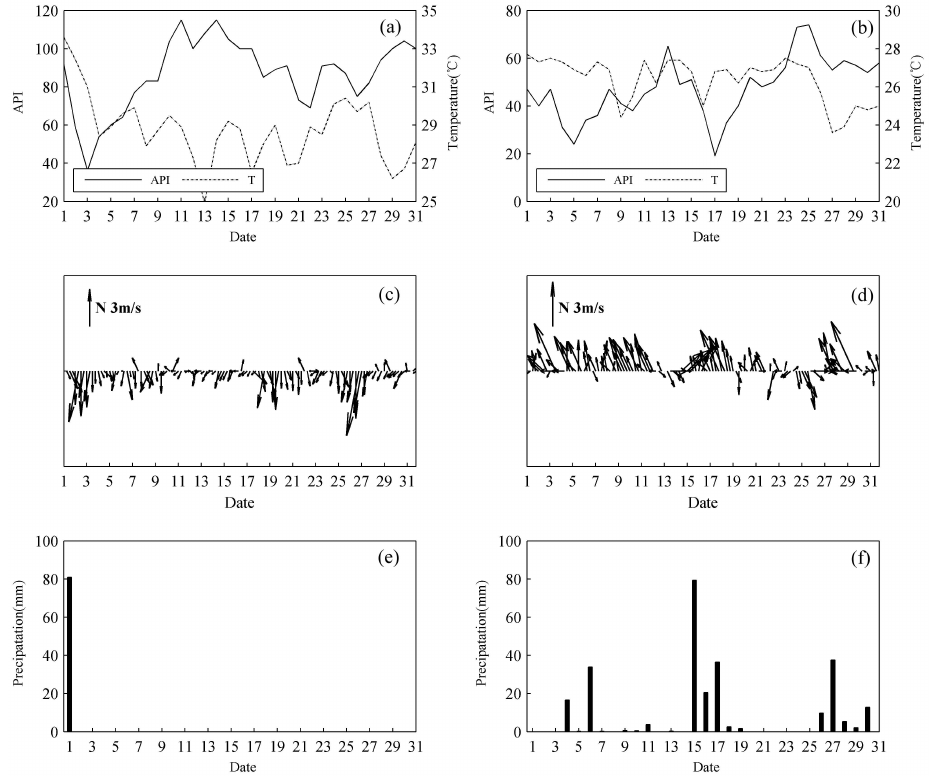
Fig. 2. Time series of (a) API and daily temperature from 1 to 31 October 2004 at Guangzhou station; (b) API and daily temperature from 1 to 31 July 2006; (c) six-hourly wind vectors from 1 to 31 October 2004; (d) six-hourly wind vectors from 1 to 31 July 2006; and daily amount of precipitation from (e) 1 to 31 October 2004 and (f) from 1 to 31 July 2006.